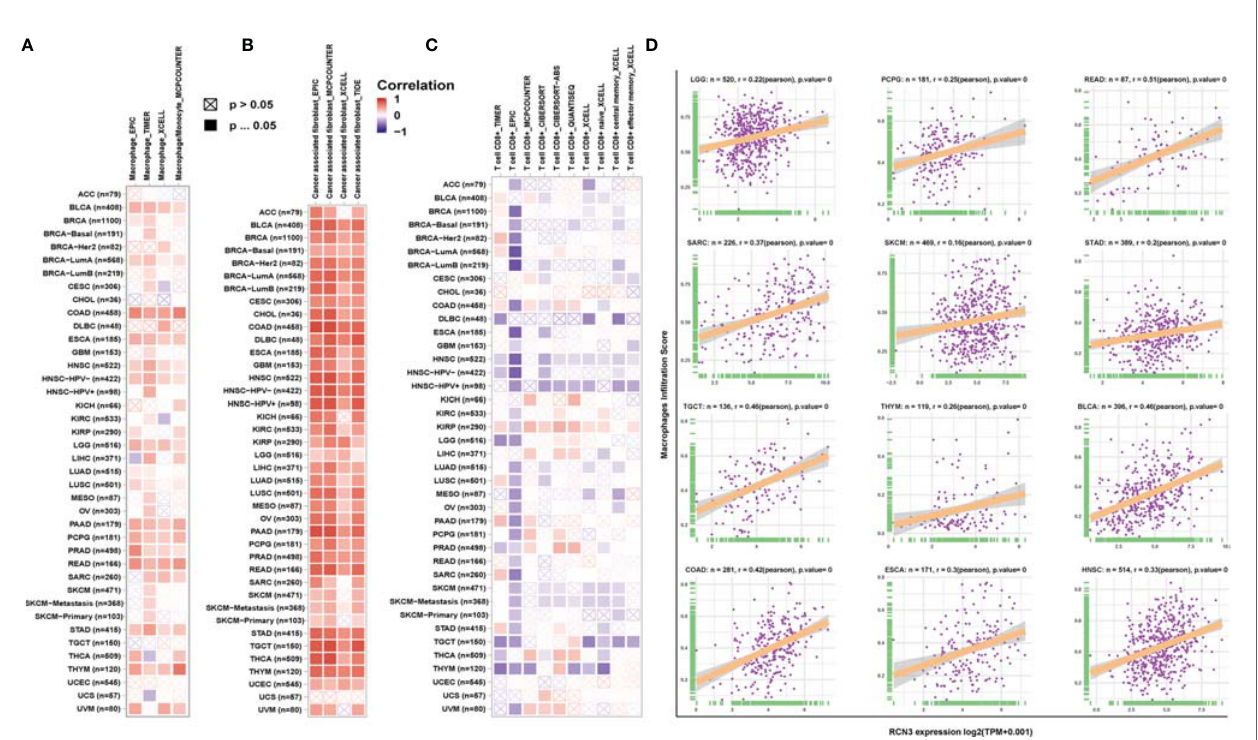
FIGURE 7 | Relationship between RCN3 expression and in fi ltration levels of immune cells. Based on the TIMER2 database, we analyzed the potential correlation between the expression level of the RCN3 and the in fi ltration levels of tumor-associated macrophage (A) , cancer-associated fi broblasts (B) , and CD8+ T cells (C) . (D) Correlation analysis of RCN3 expression with macrophages in fi ltration score in cancers from TCGA by CIBERSORT.